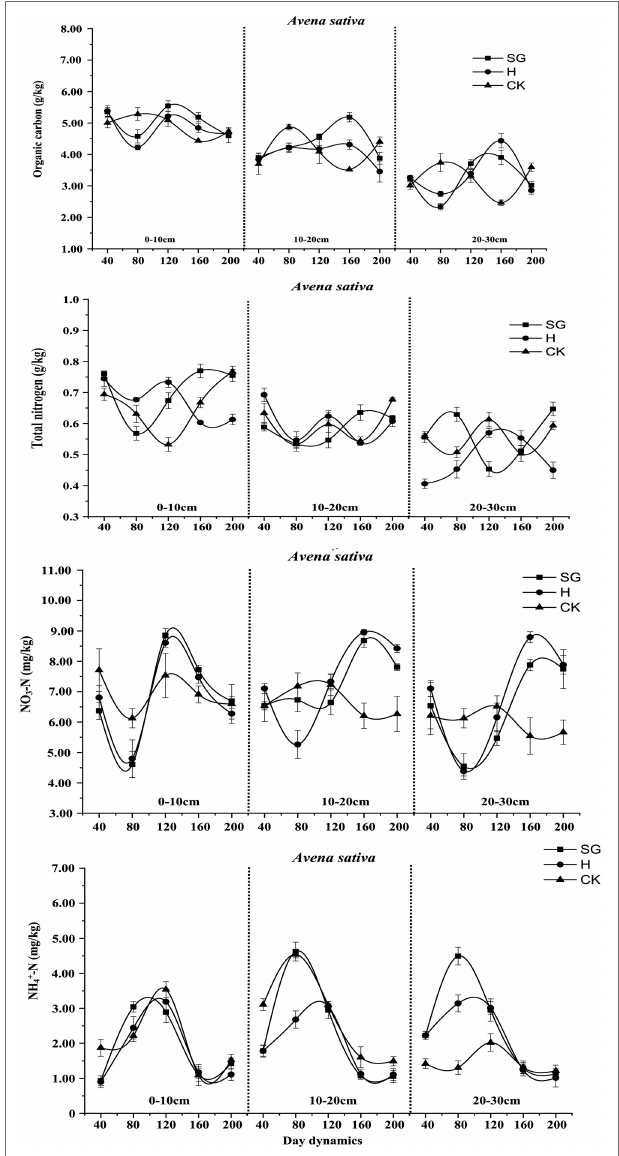
FIGURE 9 | Dynamic changes of soil nutrients of Avena sativa